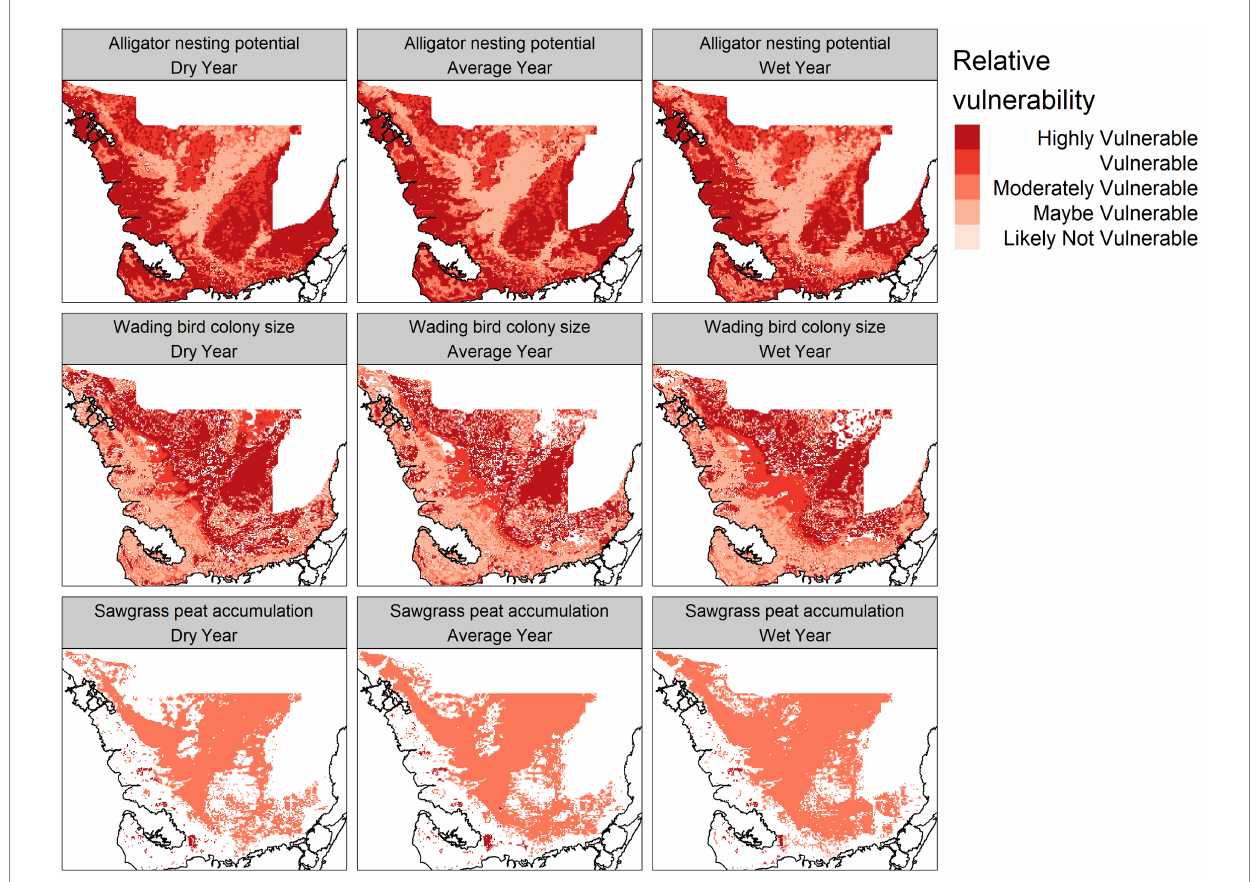
FIGURE 8 Predicted vulnerability (distance from a user-defined target state, standardized from 0 to 1) of the alligator nesting potential, wading bird colony size, and sawgrass peat accumulation modules for a dry (2014), average (2007), and wet (2003) year chosen from 2000 to 2017.